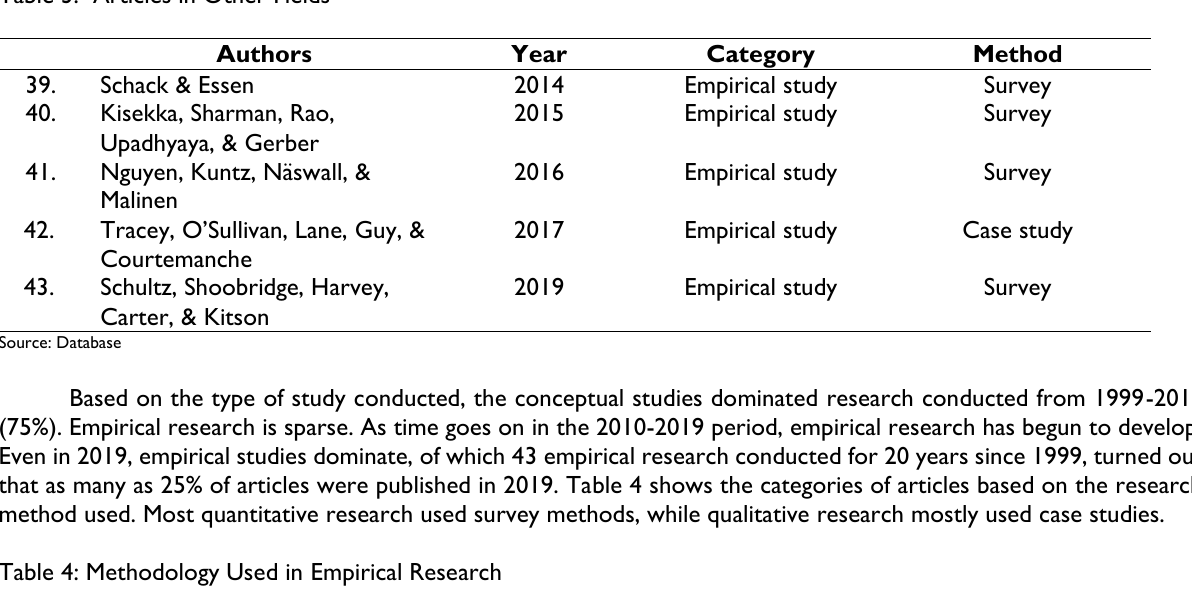
Table 4: Methodology Used in Empirical Research Quantitative Qualitative Mixed Method Total Survey